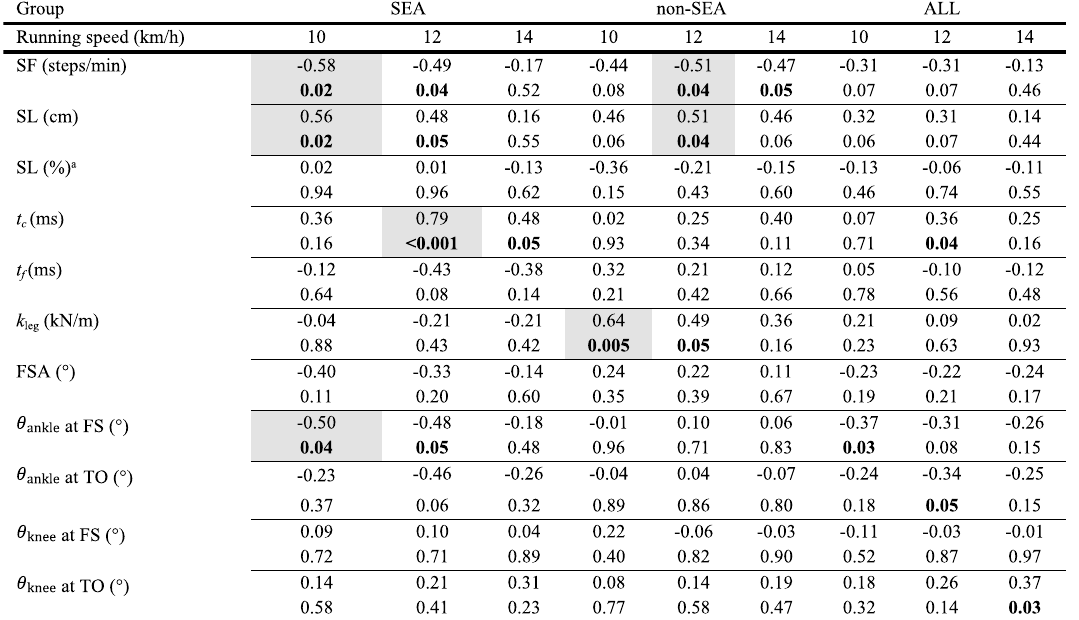
Table 6. Pearson correlation coefficients between running economy and biomechanical variables [step frequency (SF), step length (SL), contact time (t c ), flight time (t f ), spring-mass characteristics of the lower limb as given by leg stiffness (k leg ), footstrike angle (FSA), and flexion–extension ankle ( θ ankle ) and knee ( θ knee ) joint angle at footstrike (FS) and toe-off (TO)], together with their corresponding p -values underneath for South East Asian (SEA), non-South East Asian (non-SEA), as well as all runners pooled together (ALL). Statistical significances ( p ≤ 0.05) are indicated in bold. Gray shaded boxes denote correlation coefficients above an absolute value of 0.5 (moderate). SL was expressed as a percentage of participant’s leg length in addition to raw units. a Step length normalized to leg